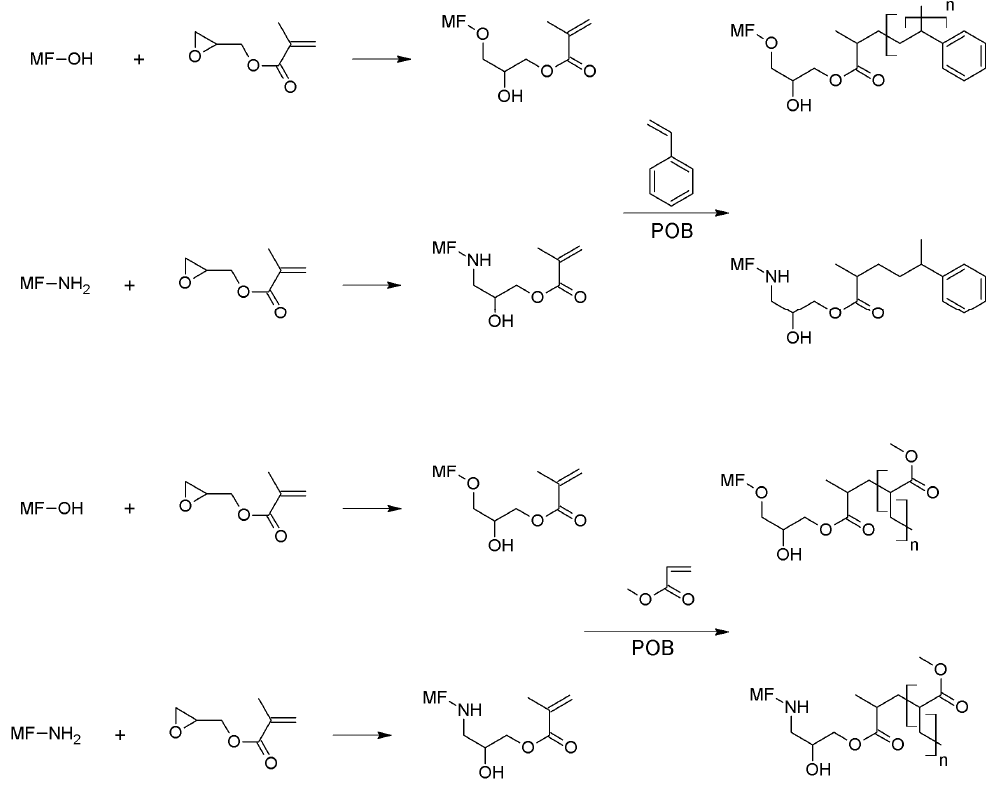
Figure 2. Proposed reaction between MF microcapsules, GMA, and styrene or methyl methacrylate. Table 1. Composition of the double-layered shell